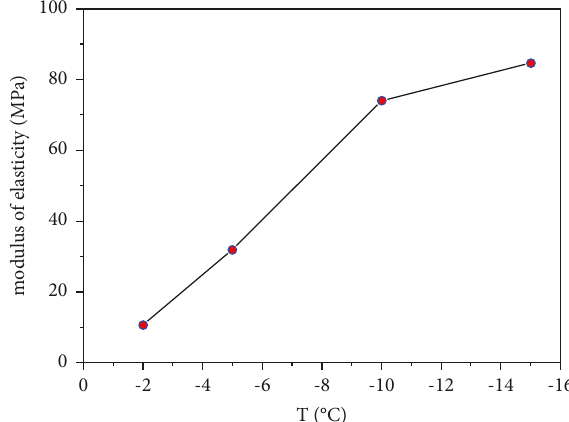
Figure 5: The relationship between the modulus of elasticity and